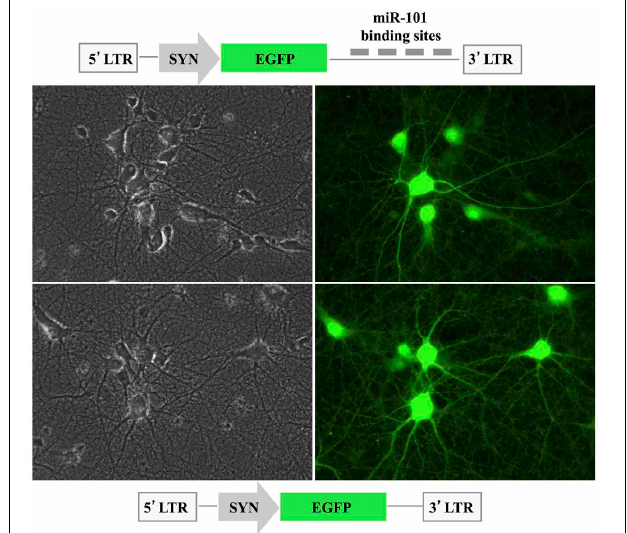
FIGURE 2 | Expression of the pLSyn-miR-101 sponge in primary hippocampal neurons. A schematic representation of the pLSyn-miR-101 sponge and the control pLSyn lentiviral vector is shown. The EGFP signal was slightly lower in the pLSyn-miR-101 sponge-containing neurons (top image) at 14 days post-transduction with respect to the pLSyn-containing neurons (bottom image). Left: phase contrast images, right: EGFP